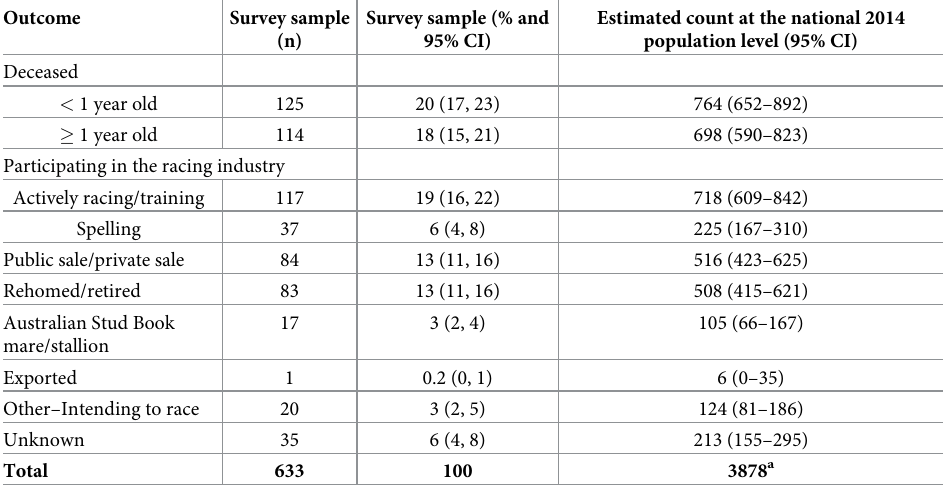
Table 6. Extrapolation of survey results to the total number of horses that had not registered an official stable return prior to 1 August 2018. Outcome Survey sample Survey sample (% and Estimated count at the national 2014 (n) 95% CI) population level (95%